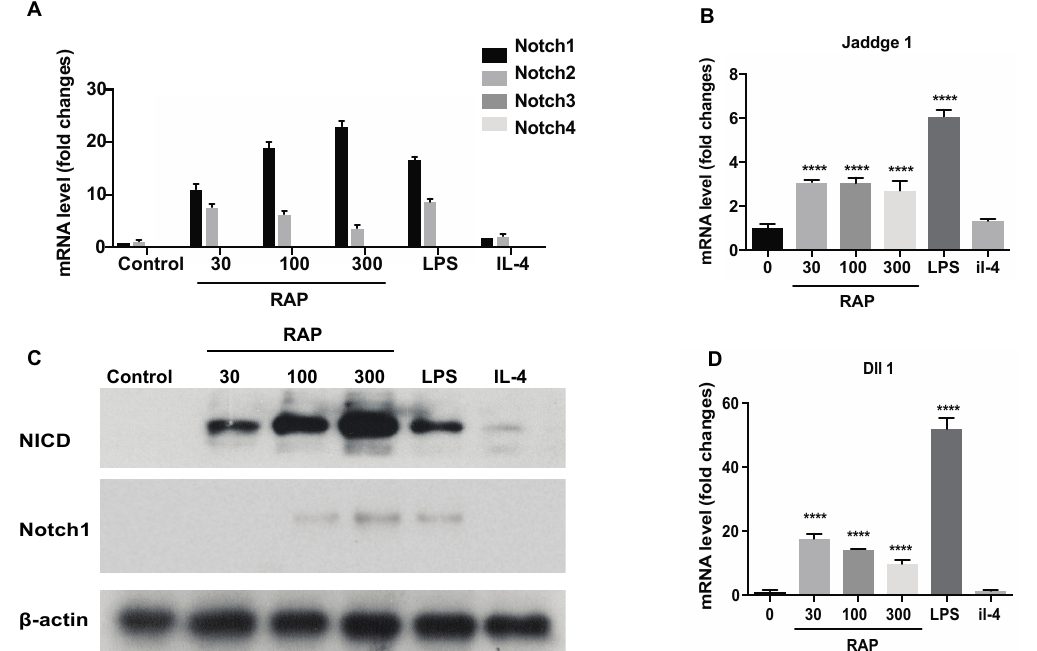
Figure 5. Gene expression of Notch signaling pathway induced by RAP. The RAW264.7 cells were stimulated with 30 µ g / mL, 100 µ g / mL, and 300 µ g / mL of RAP, 1 µ g / mL of LPS, and 20 ng / mL of IL-4 for 24 h. Gene expression levels of Notch1, Notch2, Notch3, Notch4 ( A ), Jaddge 1 ( B ), Dll1 ( D ) were measured by real-time PCR and normalized to that of β -actin. Values are shown as the fold-change relative to the control group. The NICD and Notch1 expression was confirmed by western blot ( C ), and β -actin was used as the control. A significant difference of each gene expression in each group was observed by one-way ANOVA test, **** p < 0.0001.